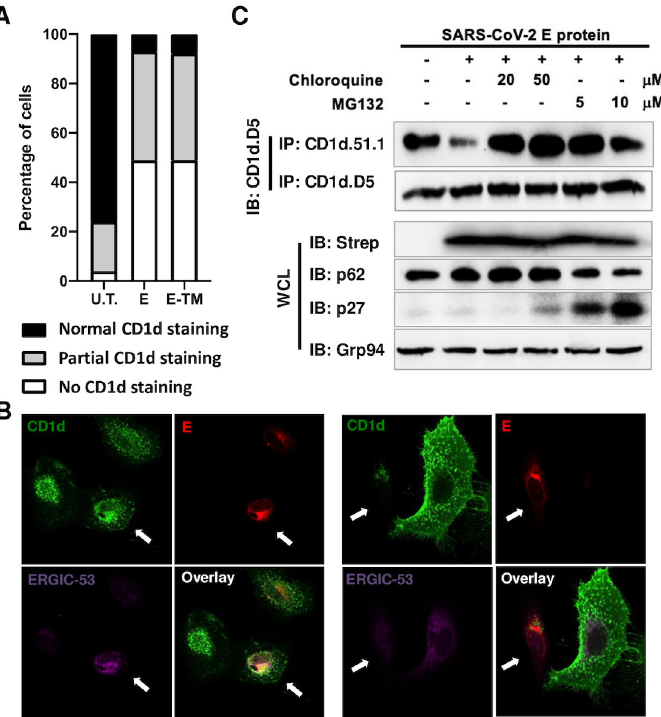
Fig 5. SARS-CoV-2 E protein leads to degradation of mature CD1d proteins in a proteasome- and lysosome- dependent manner. (A, B). HeLa.CD1d cells were transfected to express E protein. Forty eight hours post transfection, cells were fixed with 3.7% formaldehyde and subjected to co-staining with anti-CD1d (CD1d.51.1) and anti-Strep antibodies. Relative expression levels of mature CD1d protein is surveyed in HeLa.CD1d cells expressing either full- length E protein or its TM domain and compared to CD1d protein level in untransfected HeLa.CD1d cells (A). CD1d expression in HeLa.CD1d cells was categorized into three groups: normal CD1d staining, partial CD1d staining and no CD1d staining as defined in “Materials and Methods”. The percentages of HeLa.CD1d cells in each categorized group were presented. (B). Representative staining of mature CD1d and SARS-CoV-2 E protein in transfected cells expressing both E protein and CD1d. CD1d, Strep-tagged E protein and cellular ERGIC-53 proteins were co-stained and imaged. Arrows pointed to E protein-expressing transfected cells. (C). 293T.CD1d cells were transfected to express E protein and treated with MG132 or chloroquine at indicated concentrations. Cells were harvested 48 hours post transfection, lysed in 1% Triton and subjected to immunoprecipitation by anti-CD1d antibodies, CD1d.51.1 or CD1d. D5. Immunoprecipitants were blotted with anti-CD1d antibody (CD1d.D5). Whole cell lysates were blotted with p62 and p27 antibodies to verify the inhibition of lysosomal or proteasomal degradation. Grp94 protein was blotted as loading controls for all